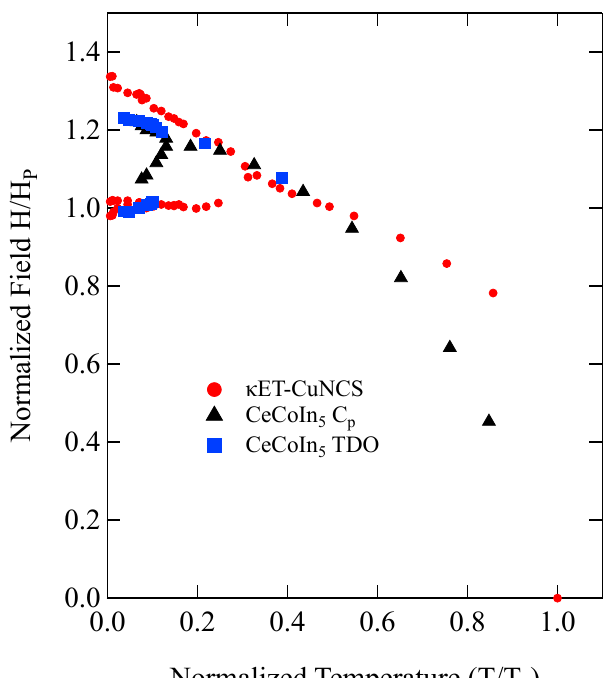
Figure 9. Color online. Phase diagram of CeCoIn 5 with κ ET-CuNCS as our baseline FFLO phase diagram. If the magnetic field is normalized by H P as calculated by Equation (6), the TDO measurement [64] (blue squares) finds a phase line at H P . NMR experiments [100] confirm a change of the material properties at this field value too, suggesting that there may be a FFLO type transition at the calculated H P . The more vertical phase line discovered by specific heat [54] (black triangles) at about t = 0.1 could be related to the